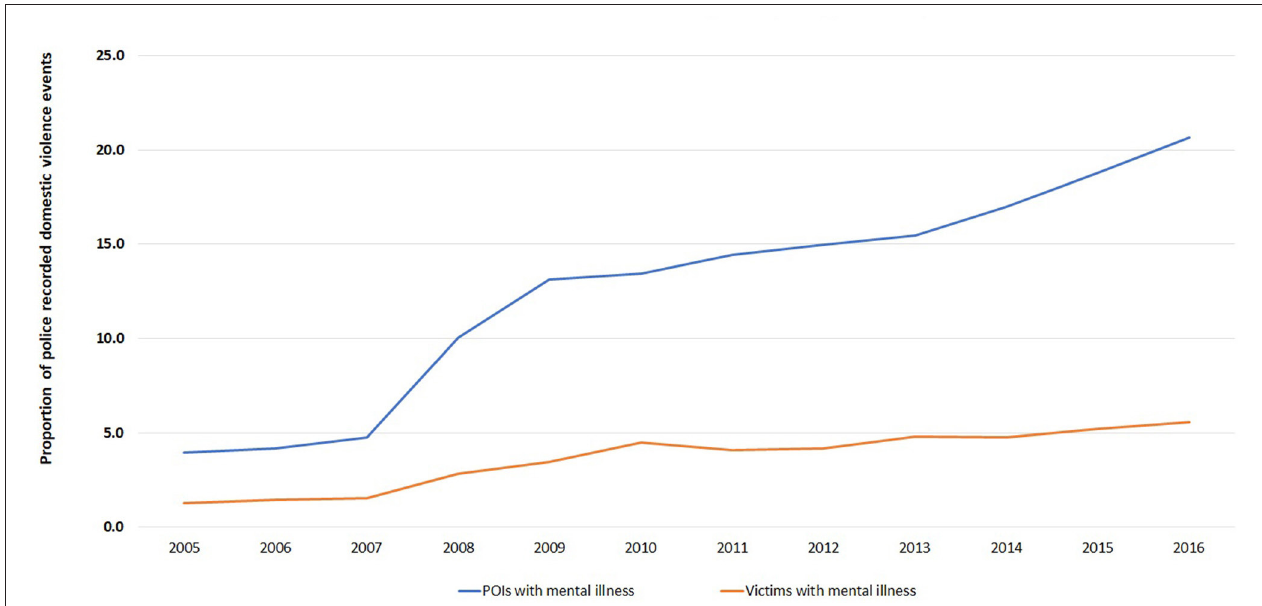
FIGURE 9 | Trend in the proportion of police recorded domestic violence events that had a mental illness for either a POI or a victim in NSW ( N = 64,587), January 2005–December